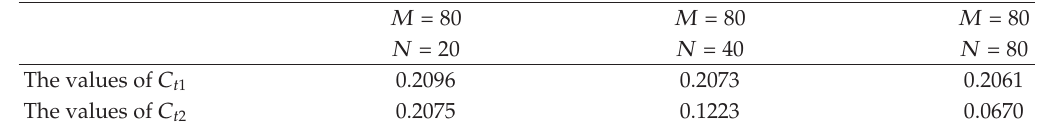
Table 1: Stability estimates for (cid:3) 2.9 (cid:4) .